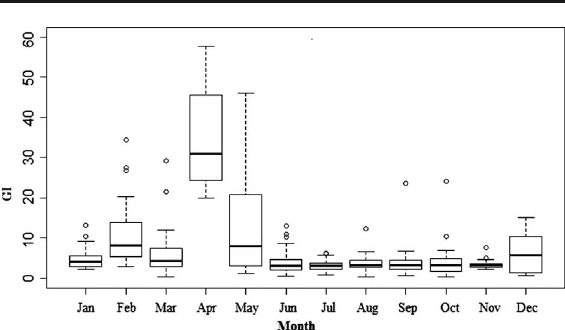
Fig. 6. – Monthly mean gonadal index (GI) of female dolphinfish, Coryphaena hippurus (n=361), caught in the vicinity of the Saint Peter and Saint Paul Archipelago between 2007 and 2011 (the bars represent the standard deviation).